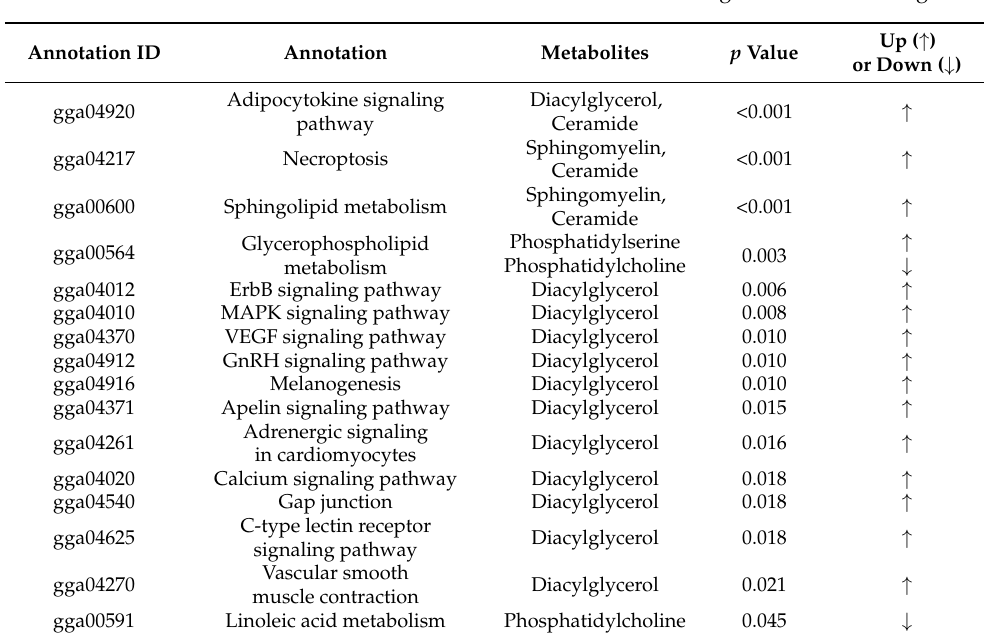
Table 3. Differential metabolites identified in liver from Huainan Partridge chicken and Nongda III .